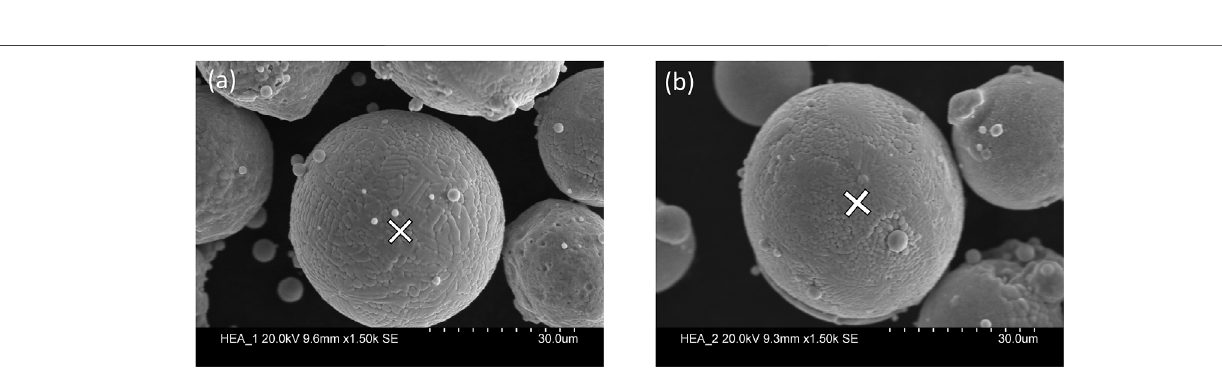
Frontiers in Materials |